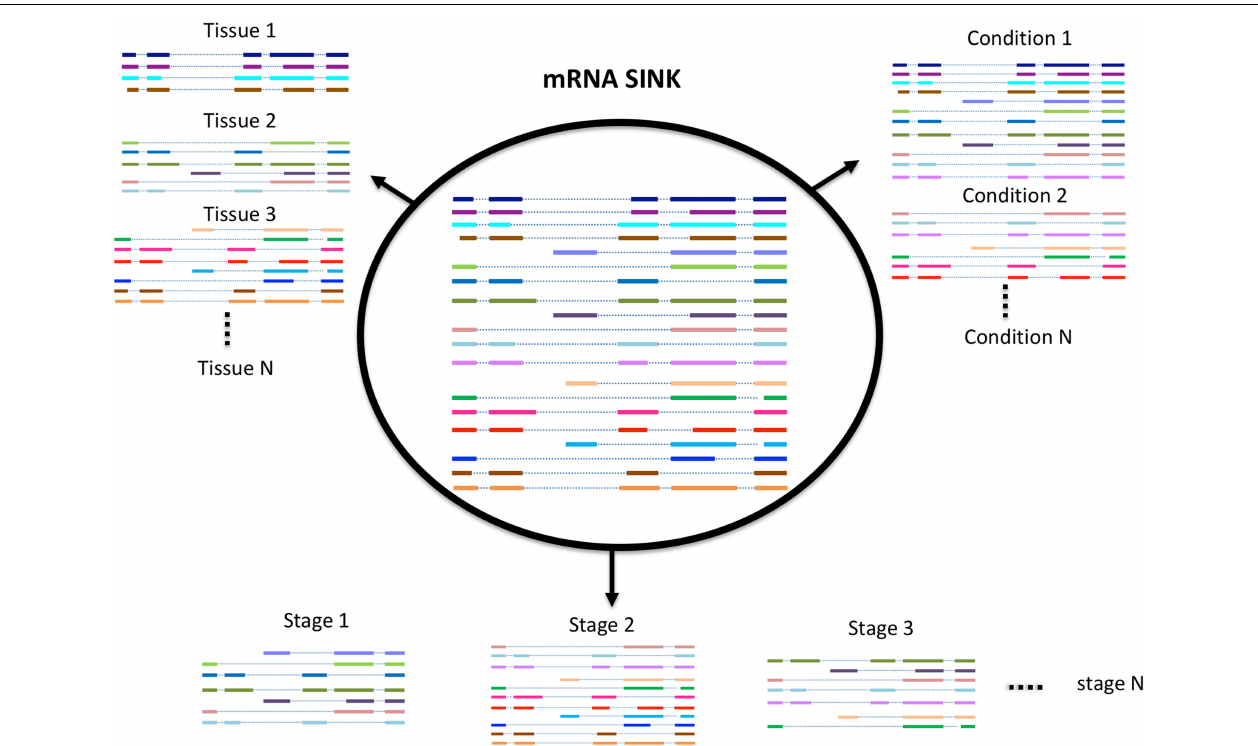
FIGURE 2 | Schematic model of alternative splicing